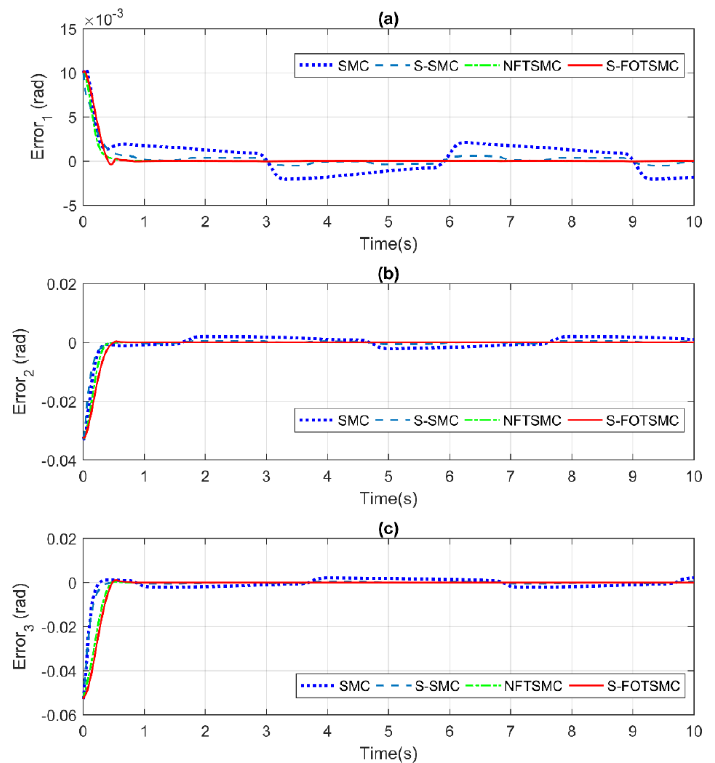
Figure 6. The tracking errors in the active joint space ( a ) at Joint 1, ( b ) at Joint 2, and ( c ) at Joint 3.